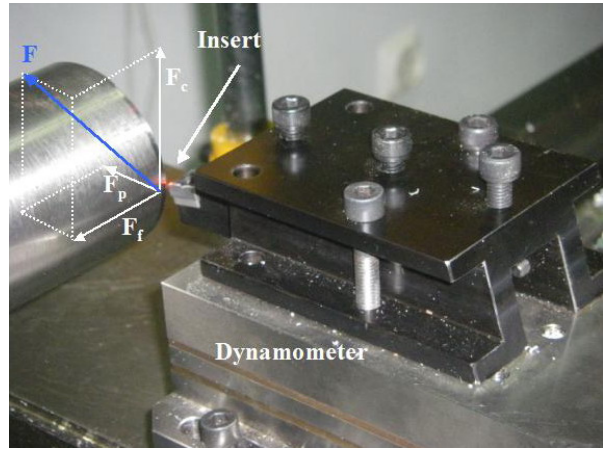
Figure 1. Assembly of the dynamometer, insert and part, and types of forces.